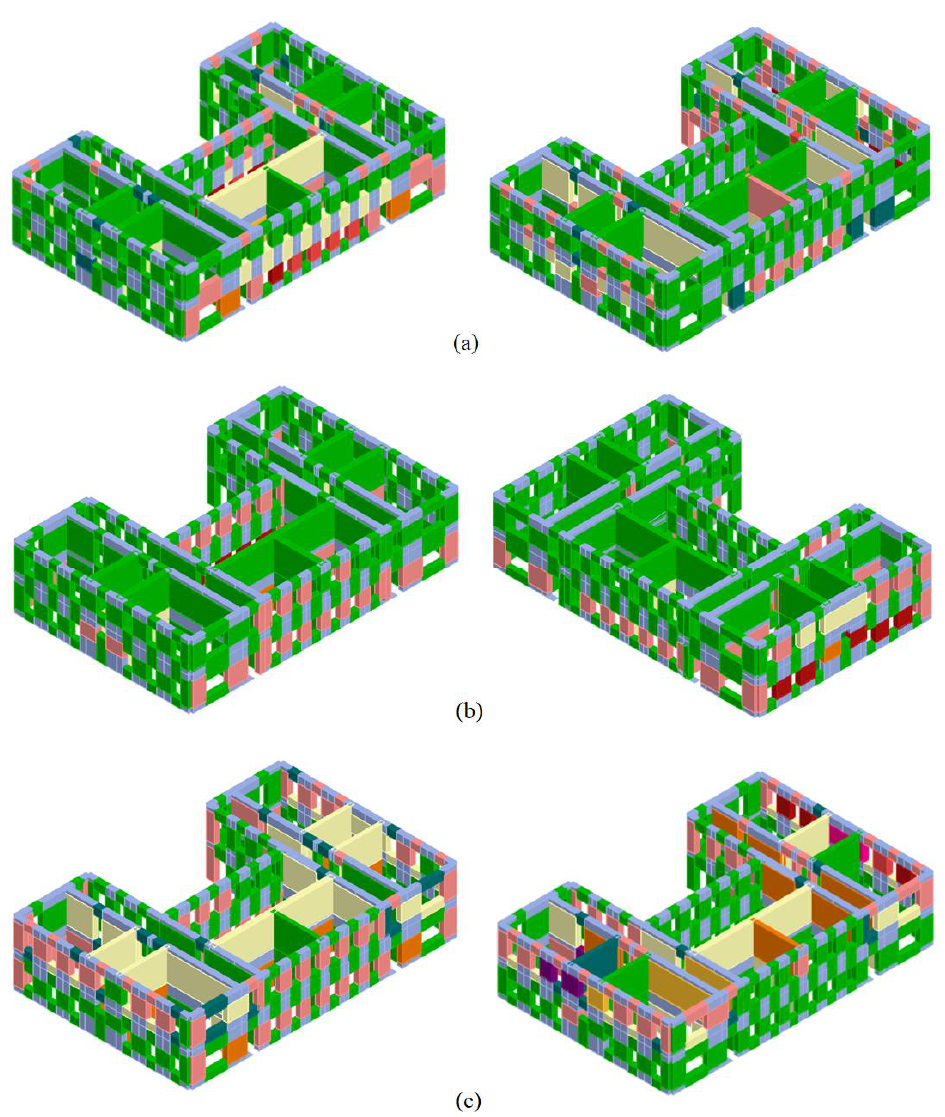
Figure 24. Three-dimensional visualization of damage in the last step of the most significant pushover analyses in x and y direction: ( a ) FRCM strengthening; ( b ) FRP strengthening; ( c ) shotcrete strengthening.